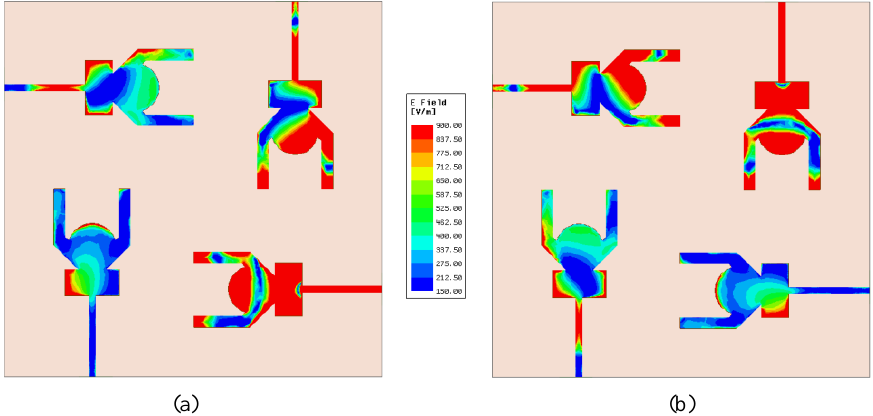
Figure 13. Electric filed distribution of proposed single element of antenna ( a ) 28 GHz and ( b ) 38 GHz.